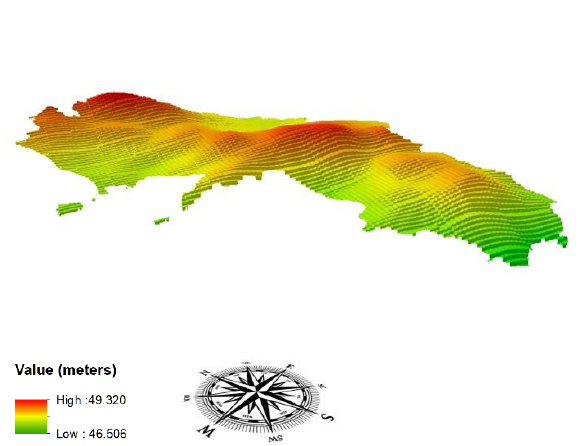
Figure 5. The local geoid model resulting from the adaptation of EGM2008 on the Campania Region based on 60 GNPs.